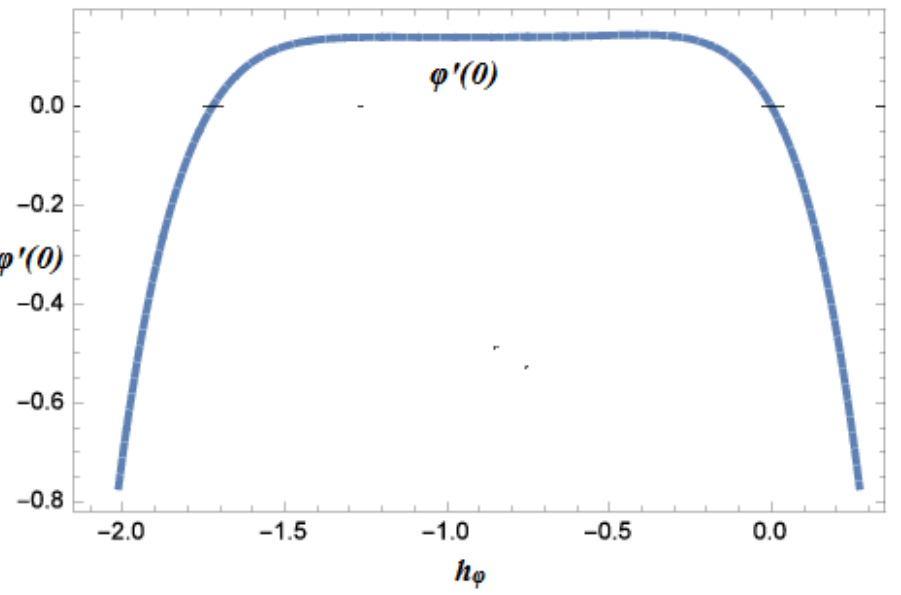
Appl. Sci. 2016 , 6 , 334 Figure 3. The graph of  ‐ curve (0)  , P r = 10, B r = 0.8, N r = 0.8, D u = 0.8, S c = 0.4, ε = 0.8, S r = 0.4, λ = Figure 3. The graph of (cid:125) -curve ϕ (cid:48) ( 0 ) , P r = 10, B r = 0.8, N r = 0.8, D u = 0.8, S c = 0.4, ε = 0.8, S r = 0.4, 0.8, Λ = 1, β = 1, S = 0.3. λ = 0.8, Λ = 1, β = 1, S = 0.3.